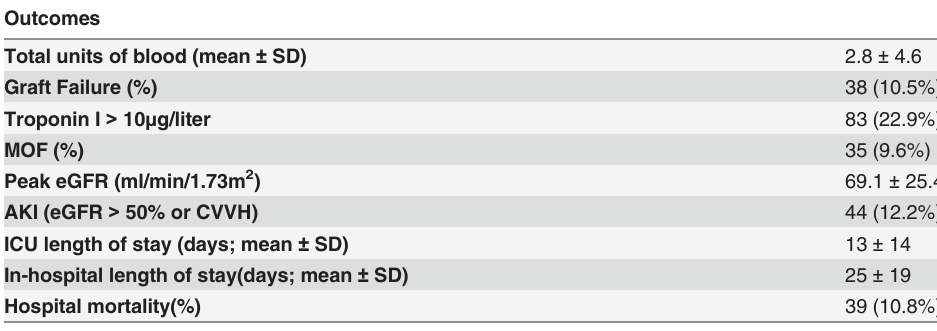
release is reported in Fig 1. Eighty-three patients (22.9% of the pts) had a troponin release > 10 μ g/L. Fig 2 shows patient distribution according to troponin release. Outcomes of patients with early troponin release > 10 μ g/L were significantly poorer (i.e. incidence of EGF: 20.5% vs 7.5%; incidence AKI: 26.5% vs 7.9%; hospital mortality rates: 20.5% vs 7.9%) Multivariable Regression modeling for EGF, AKI and fatality Univariate predictors of graft failure were: graft ischemic time, donor/recipient size matching < 0.8, previous cardiac operation, troponin I release > 10 μ g/L, hospitalization at time of trans- plant. Univariate predictors of AKI were: previous cardiac surgery, mechanical circulatory sup- port, ischemic time, extracorporeal circulation (ECC) length, troponin I release > 10 μ g/l, and transfusion of > 4 blood units. Univariate predictors for hospital mortality were: non-idiopath- ic cardiomyopathy, previous cardiac operation, hospitalization at time of transplant, donor age, early graft failure, AKI, troponin I release > 10 μ g/L and blood transfusions. Multivariable logistic regression analysis for such outcomes is summarized in Table 4. Troponin release > 10 μ g/l proved an independent predictors of EGF. EGF in turn was a prognosticator of hospital mortality. Table 3.